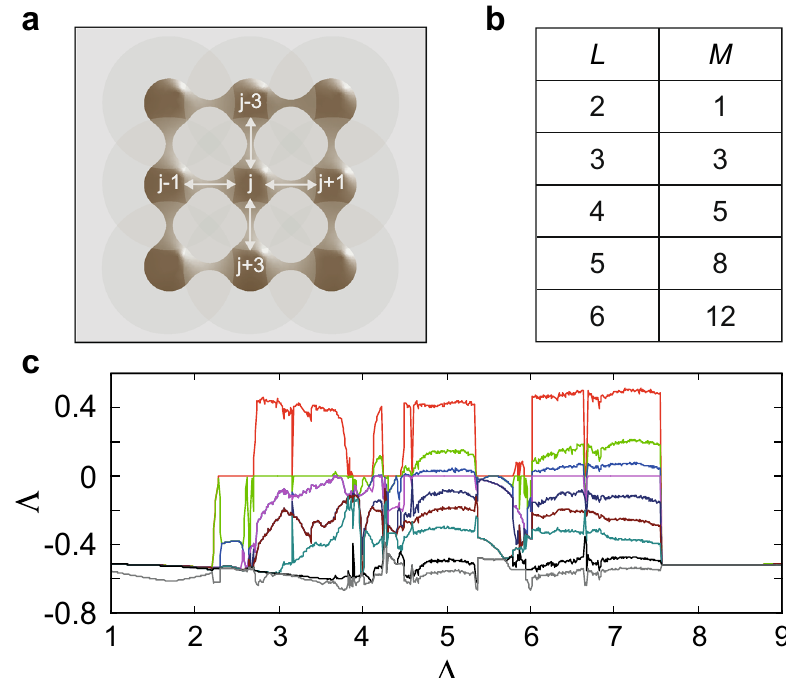
Fig. 5 2D L × L lattices of L 2 interacting qubits. a Schematic representation of a square lattice of nine interacting quantum units (e.g., Rydberg atoms or qubits), labeled by integer indexes and coupled via nearest neighbor interactions. b Number of positive Lyapunov exponents M vs. lattice size L in the L × L lattice calculated for Δ = 5, Ω = 2.0, c = 5. c Variation of the eight largest Lyapunov exponents with Δ for a square lattice of 9 qubits, Ω = 2.0.